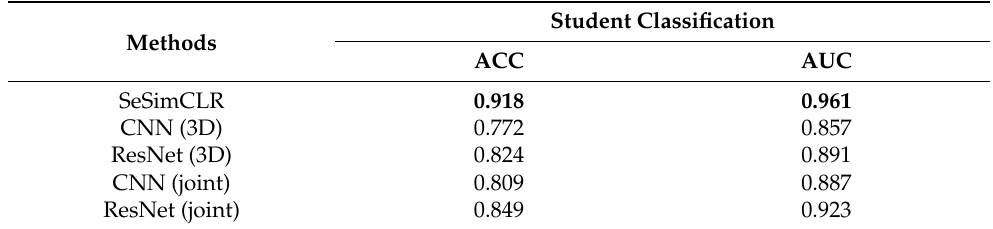
Table 2. Classification results with the classical CNN model and the popular ResNet model trained on the 3D raw MRIs and the jointed features. All results were calculated on all 123 students. Methods